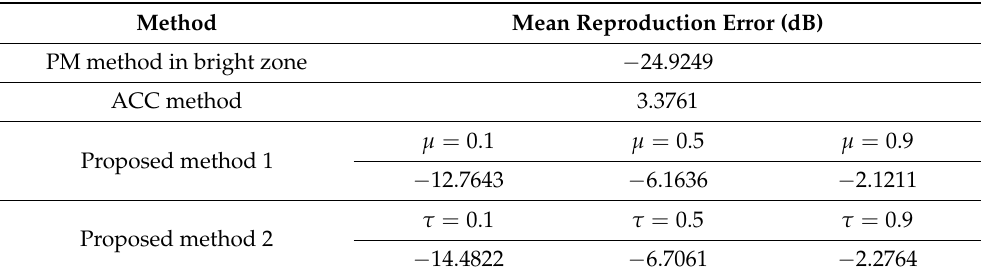
Table 4. Mean normalized spatial average error of different methods relative to frequency for two-dimensional experiment.